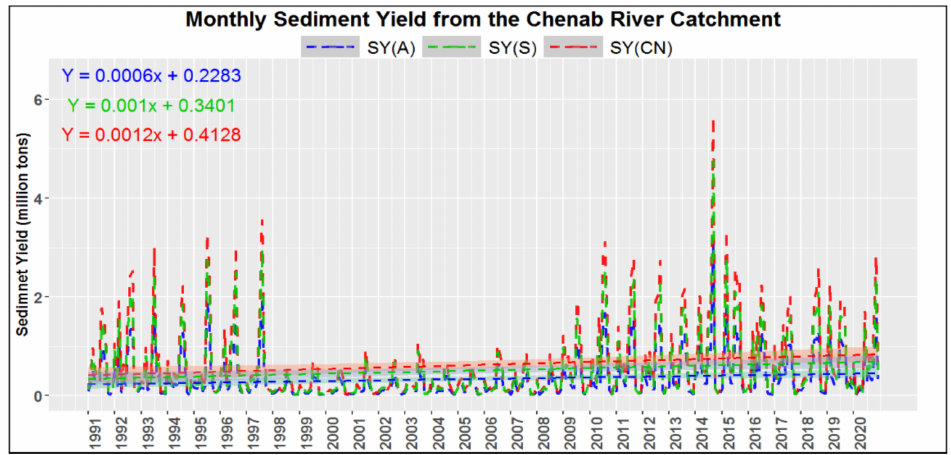
Figure 14. Monthly sediment yield from the Chenab river catchment from 1991 to